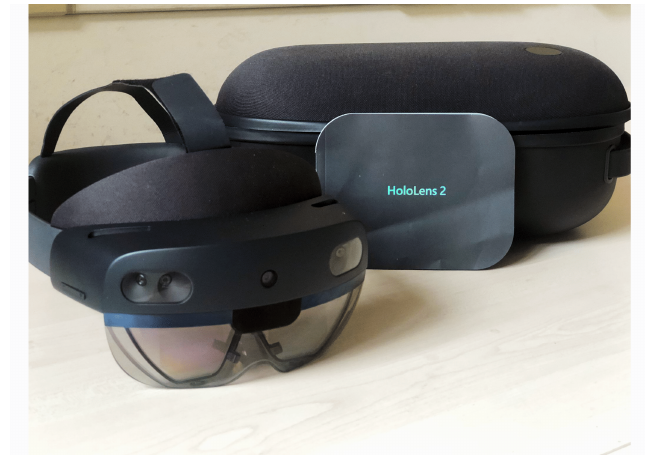
Figure 2. Example of HMD, HoloLens 2 (Microsoft, WA, USA) .